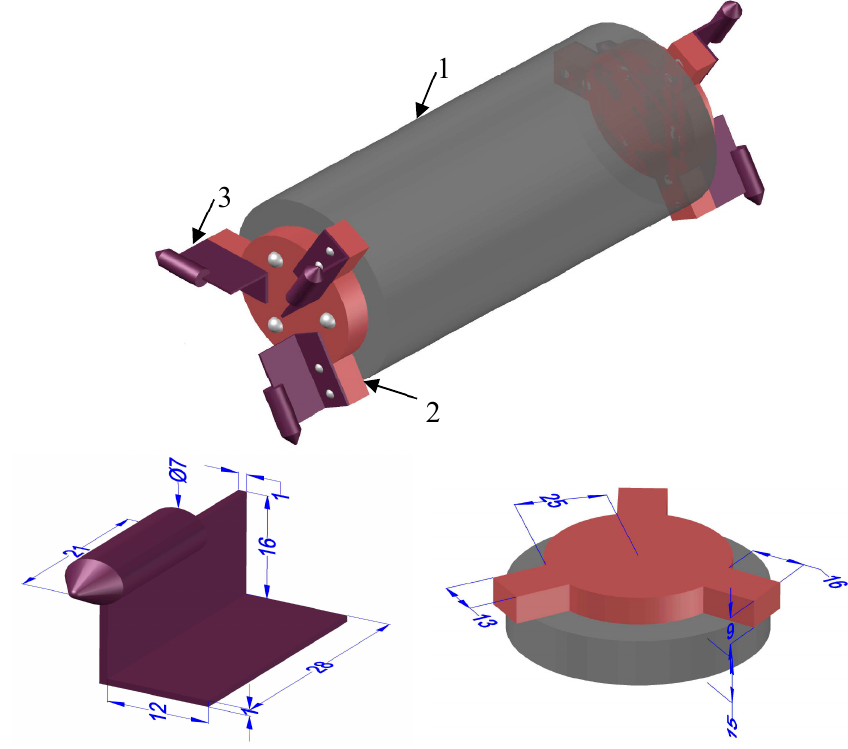
Figure 1. The structural sketch of capsule. 1, container; 2, sealing cover; 3, support foot.